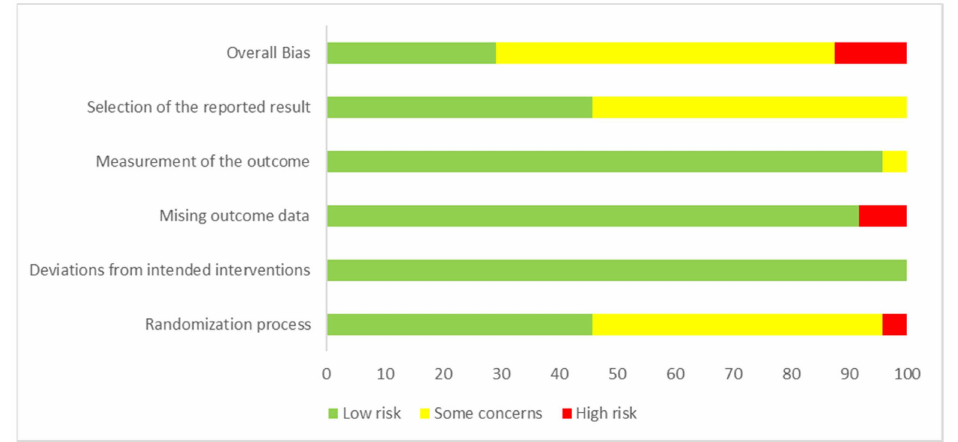
Figure 2. Summary of the risk of bias by the Cochrane risk of bias tool for randomized trials (RoB